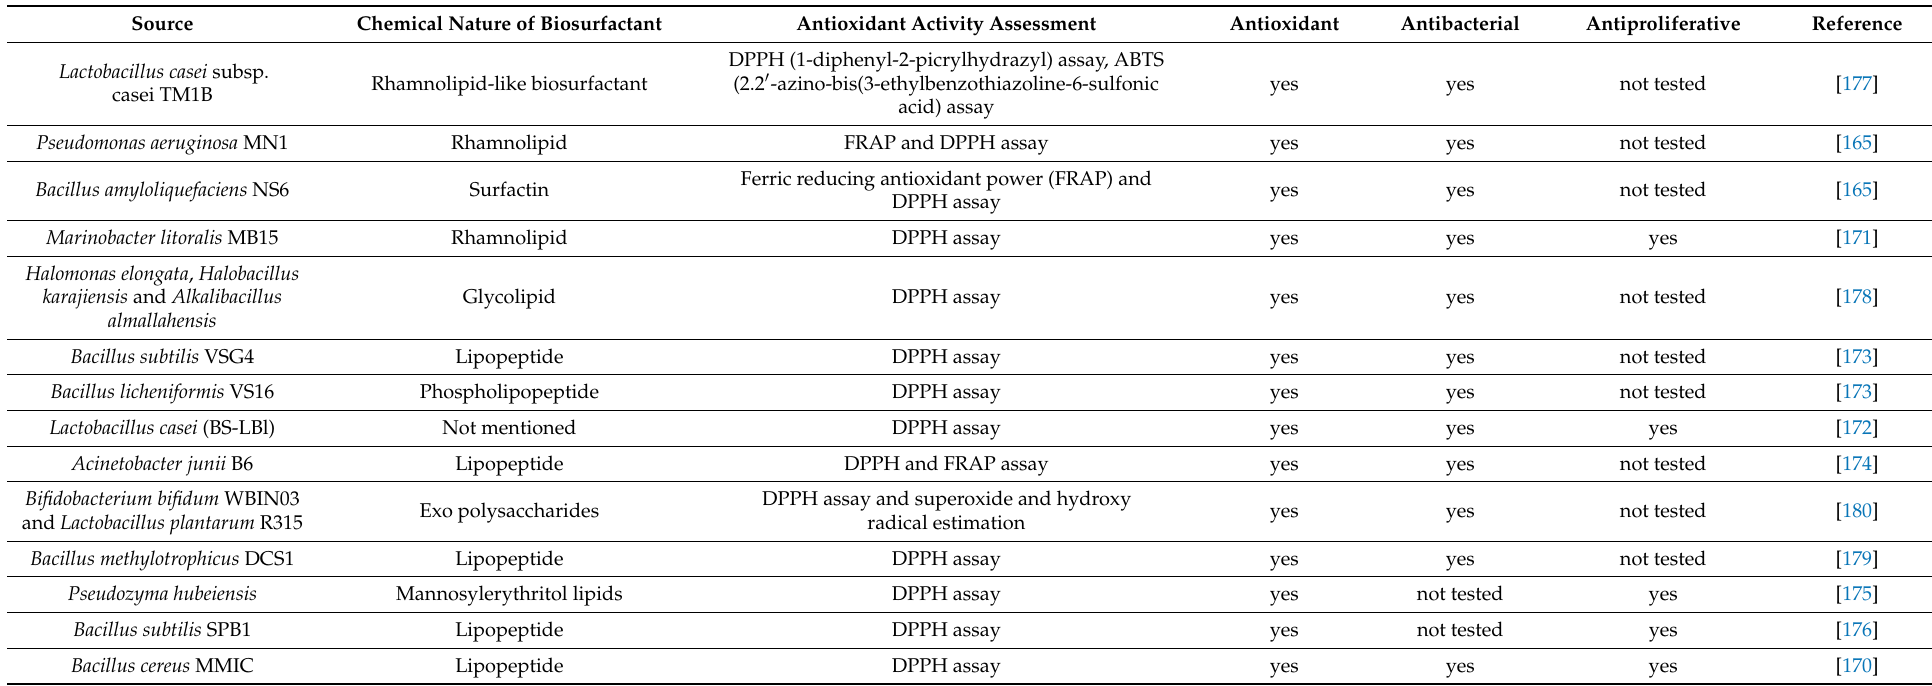
Table 6. Antioxidant properties of